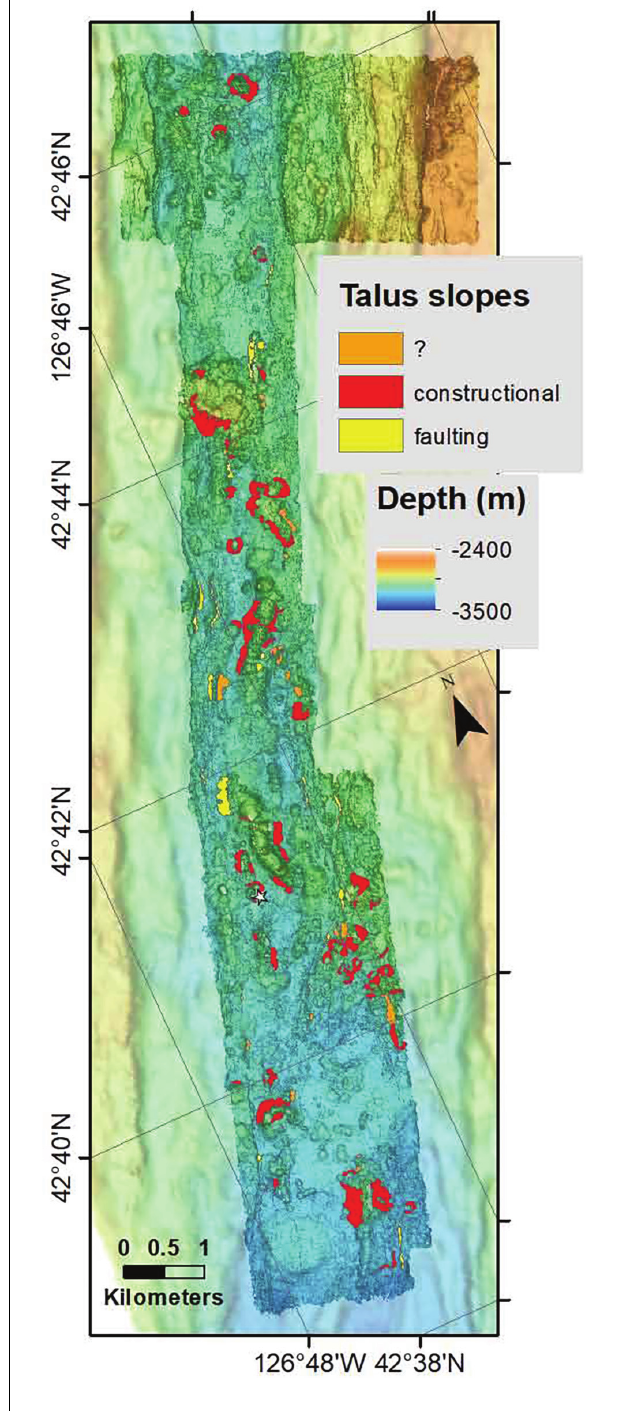
FIGURE 11 | Map showing the distributions of syn-eruptive talus and talus along fault scarps in the axial graben. Talus around the 1996 flow contains lavacicle fragments formed during the eruption as lava cascaded over near-vertical scarps (location marked with white star). This constructional talus forms a sloping surface around the base of steep-sided hummocky flows and constitutes the majority of talus in the mapped area. Talus accumulated at the base of fault scarps is also shown, as are some talus deposits that could be either constructional or fault-related. Map is rotated 23 ◦